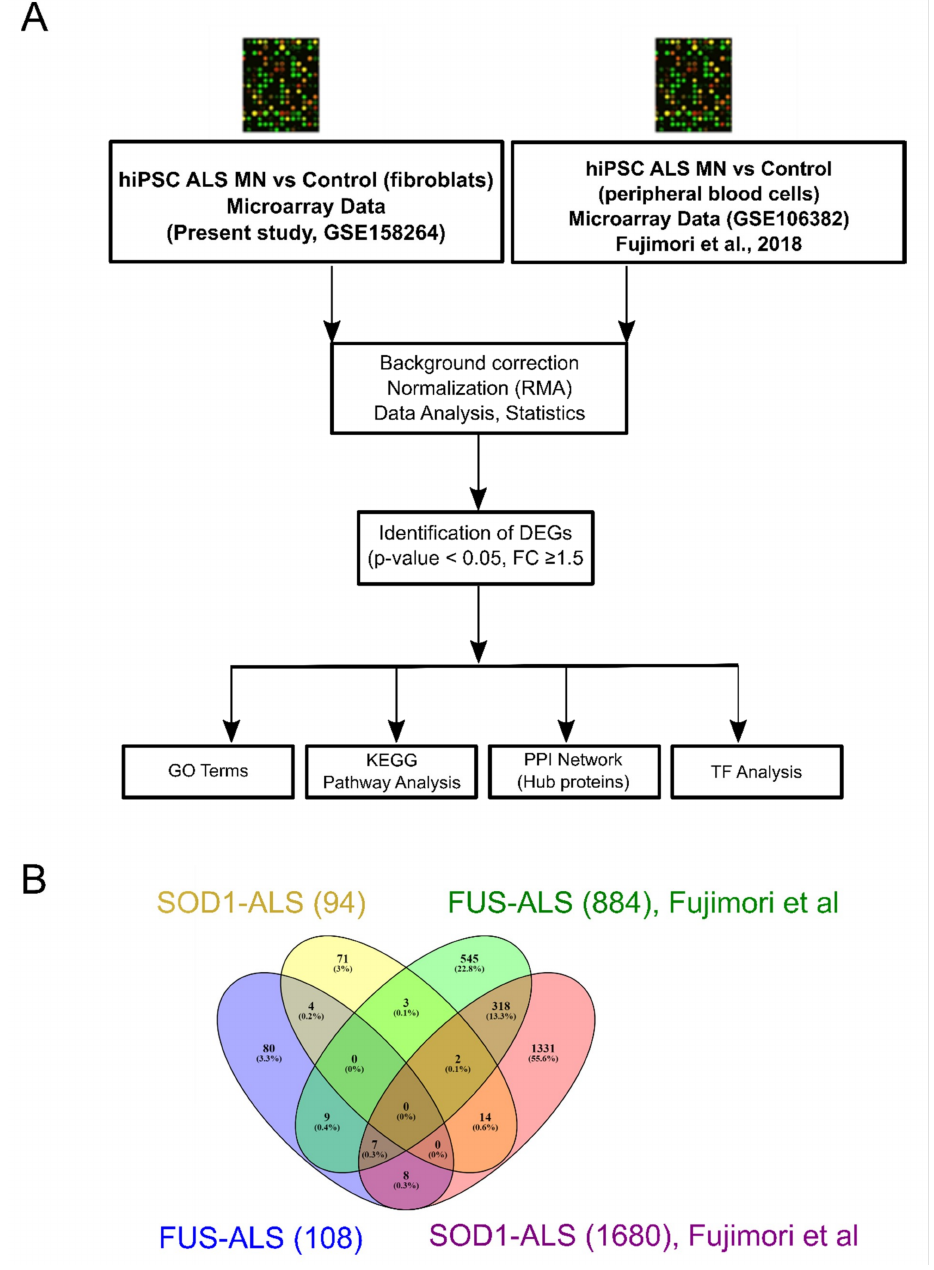
Figure 1. Overall comparison showed no common genes when comparing all datasets. ( A ) Workflow of the study. ( B ) Venn diagram representing all possible combinations of di ff erentially expressed genes (DEGs) across FUS- and SOD1-ALS datasets (present study (GSE158264) and GSE106382). Of note, no common “ALS” DEGs were identified when comparing all